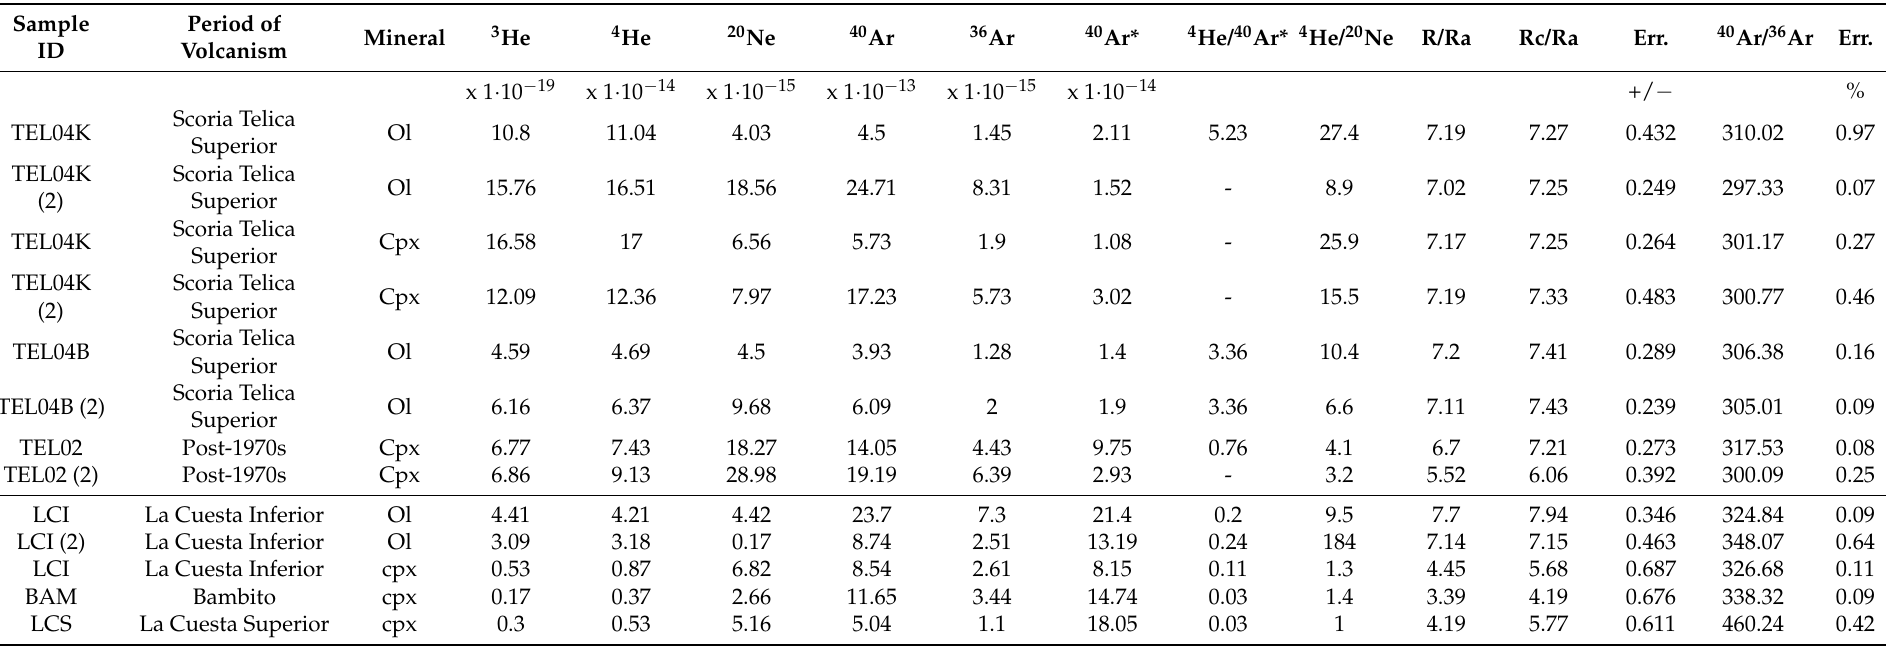
Table 1. Concentrations (in mol/g) and isotope compositions of noble gases in fluid inclusions of olivine and clinopyroxene from Telica and Baru